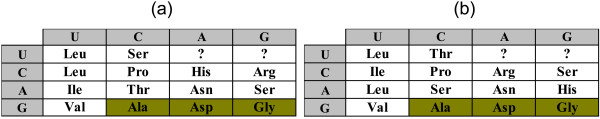
Error minimization levels of 2-letter codes. (a) A 2-letter code similar to that in Figure but with fixed assignments for 3 amino acids (dark green); (b) optimal code found by permutation of amino acid assignments in (a), MP = 0.91.